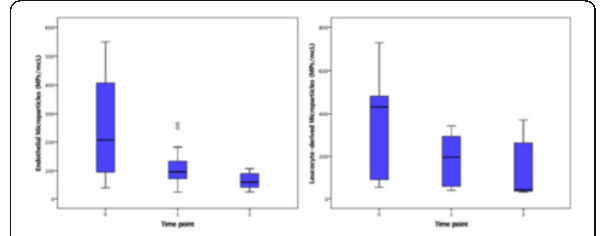
Fig. 31 (abstract A79). Endothelial and Leucocyte-derived circulating Microparticles (MPs) at T0: just before ECMO, T1: two days after ECMO start, and T2: two days after